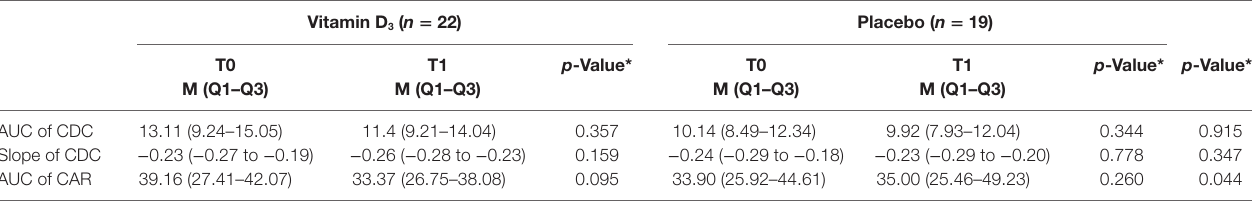
Table 3 | Within and between group comparisons for circadian cortisol levels.